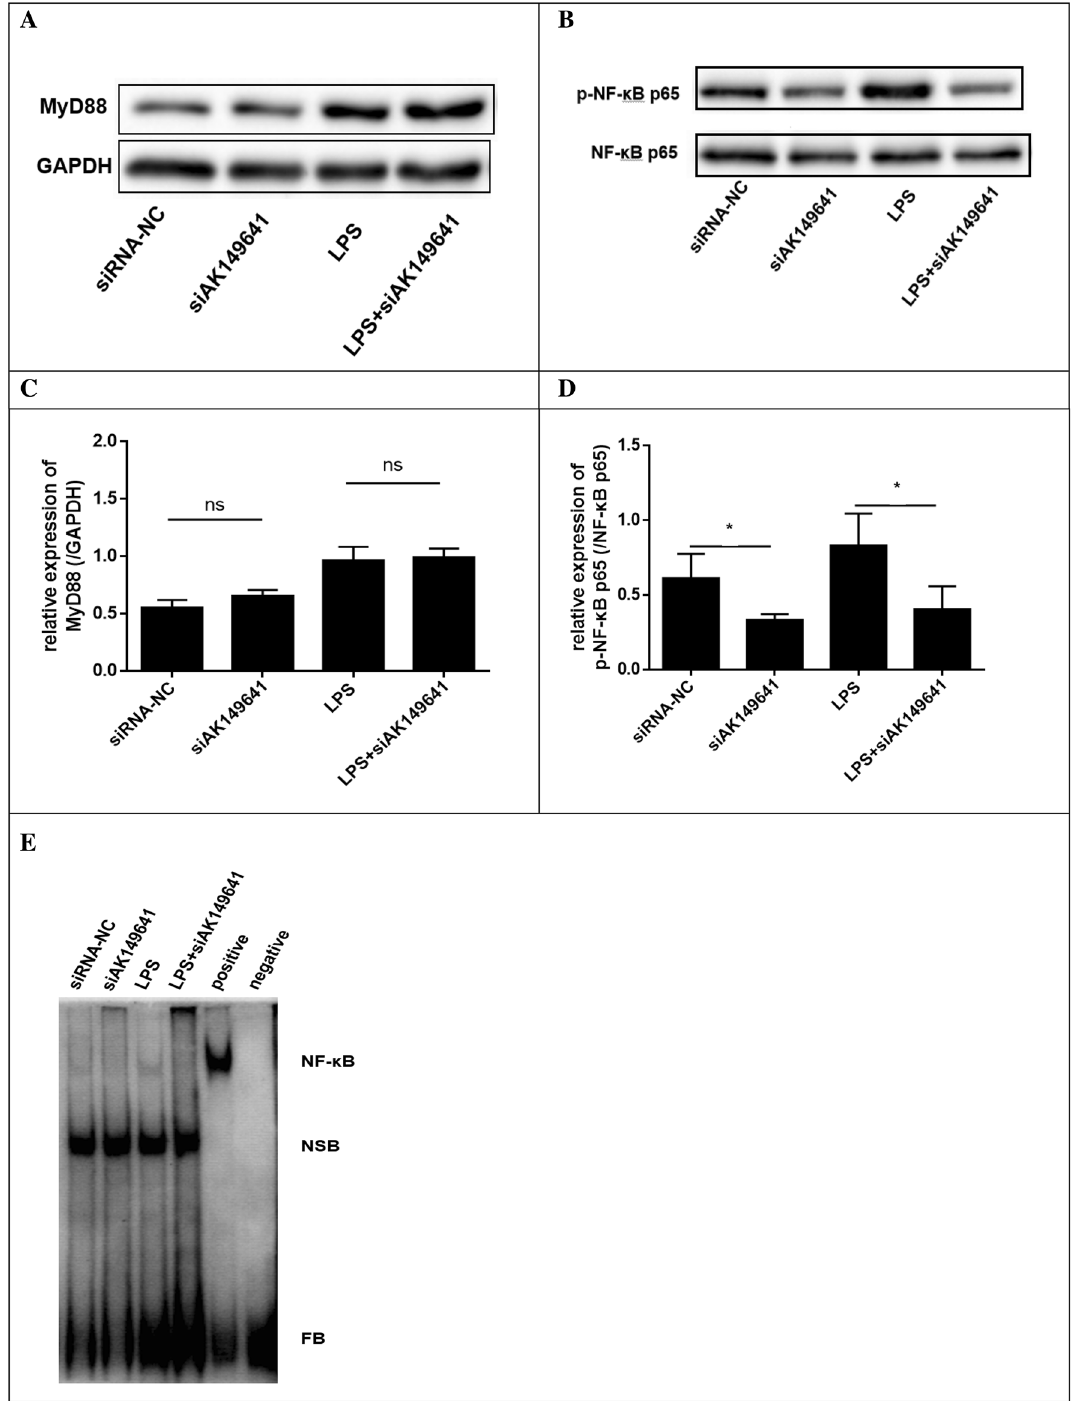
Figure 5. Changes in NF-κB expression in response to different lncRNA-AK149641 levels. ( A – D ) Western blots showing the expression of the MyD88 and p-NF-κB p65 proteins. p-NF-κB p65 decreased in the lncRNA-AK149641 downregulated group after LPS stimulation. There was no significant difference in the expression of MyD88. ( E ) The EMSA shows that downregulation of lncRNA-AK149641 inhibits the expression of NF-κB (NSB: Non-Specific Binding; FB: Free Biotin Labeled Probe) (* P < 0.05, n =